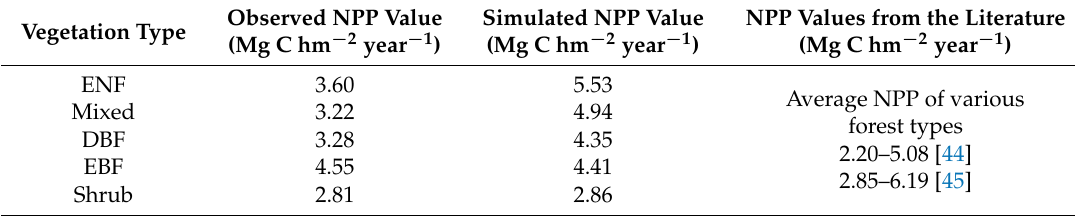
Table 3. Comparison between measured and simulated NPP values in the